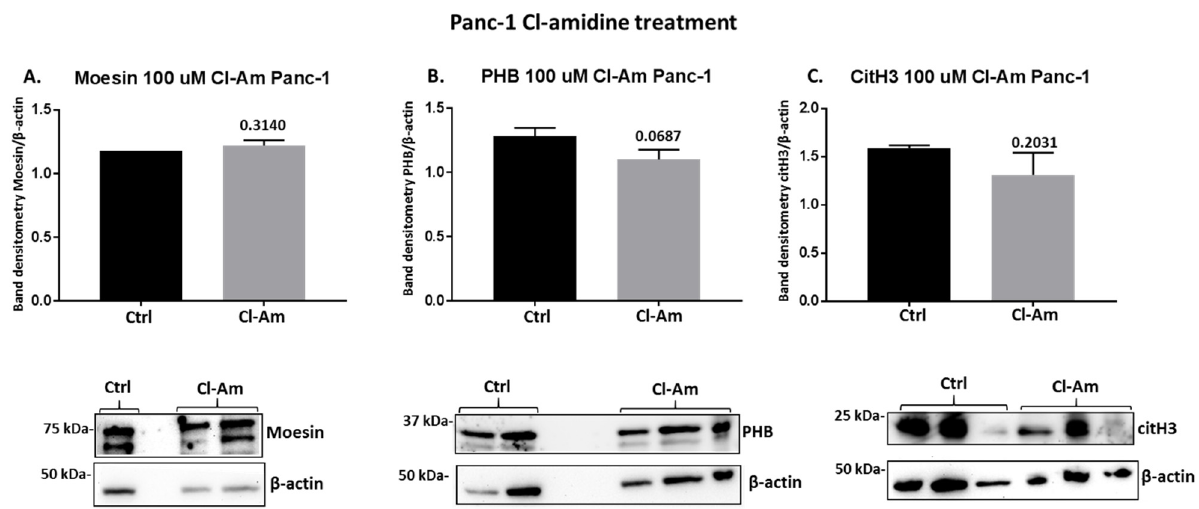
Figure 8. Changes in moesin, prohibitin, and deiminated histone H3 (citH3) protein levels in Panc-1 cells following 1 h Cl-amidine treatment. The histograms show protein levels normalised against the internal loading control ( β -actin) in treated versus control-treated cells as follows: ( A ) Moesin levels are not significantly changed; ( B ) Prohibitin (PHB) levels are slightly reduced following Cl-Am treatment; ( C ) citH3 levels are slightly reduced following Cl-Am treatment. Exact p -values are shown (significance at p ≤ 0.05 was not reached), error bars show SD ( n = 3 biological replicates for all, representative Western blots are shown beneath the respective